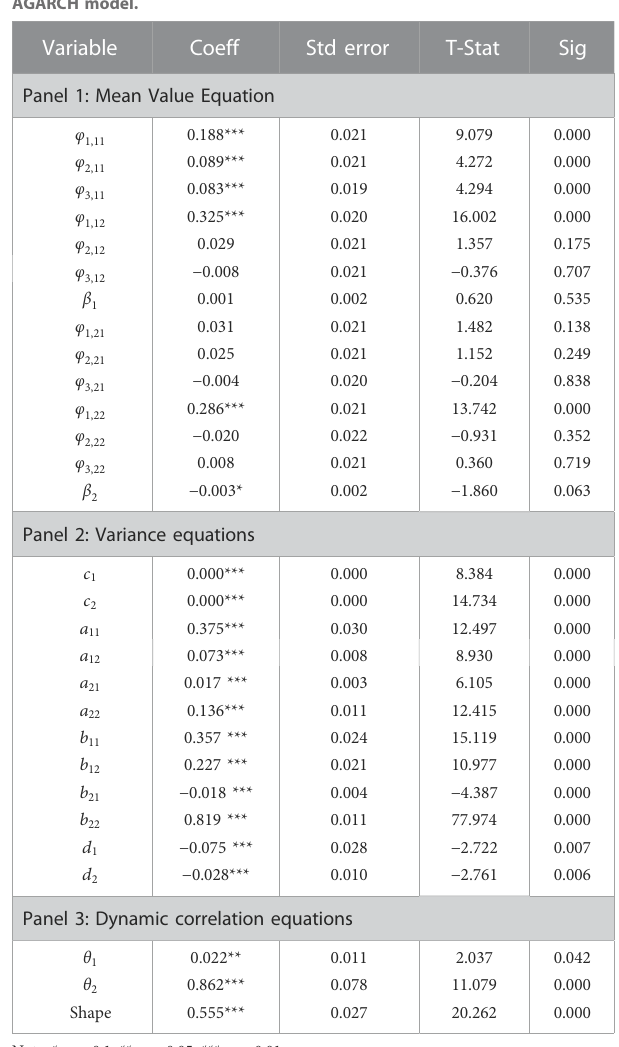
Panel 3: Dynamic correlation